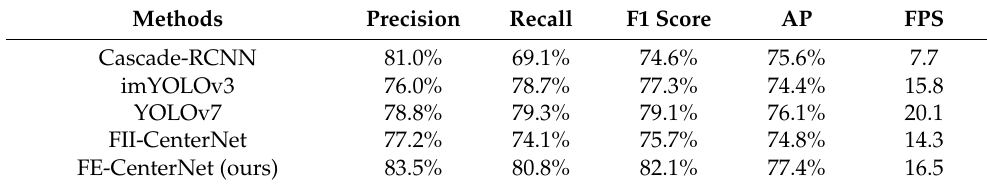
Table 2. Quantitative results of different methods.